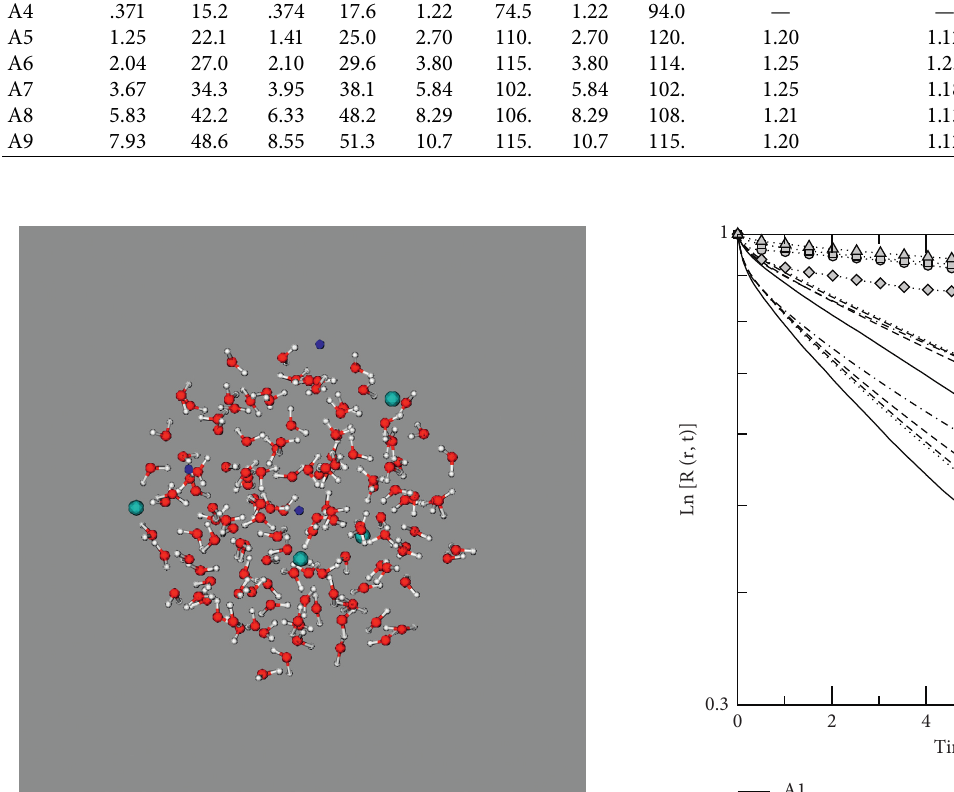
Figure 6: A snapshot of ionic atmosphere with Na+at the origin and R 1 � 9.95 ˚A from it, filled with 132 water molecules at 25 ° C. 3 Na+: dark blue and 4 Cl-: dark cyan.